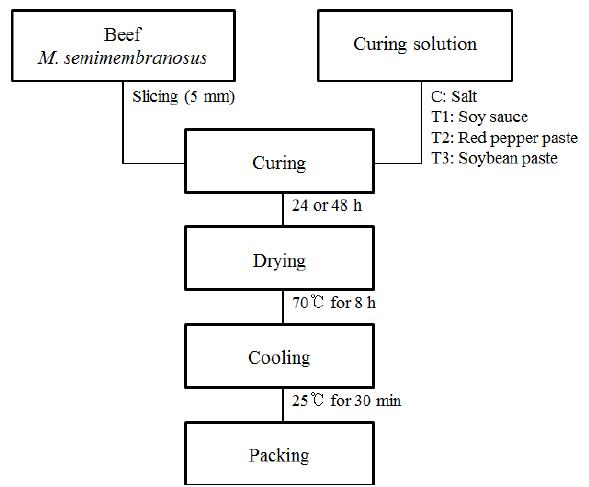
Figure 1. The diagram of beef jerky